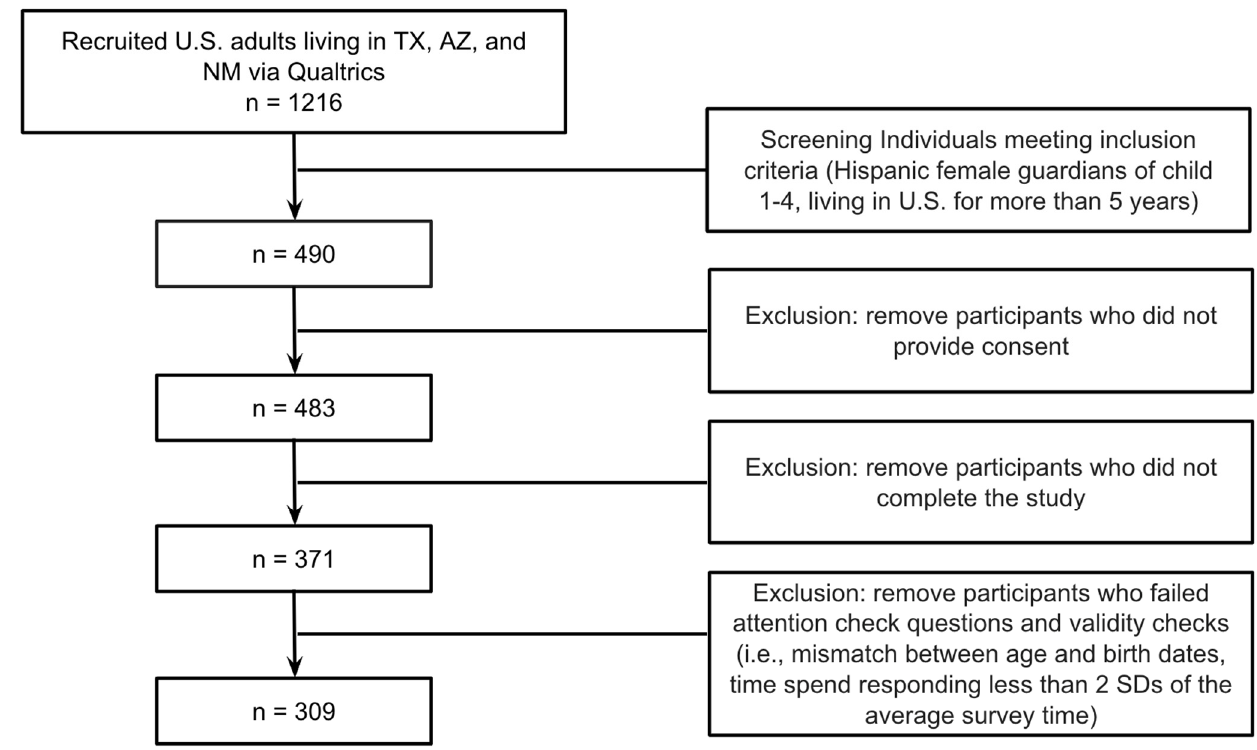
Figure 1. Flow diagram showing the recruitment process.